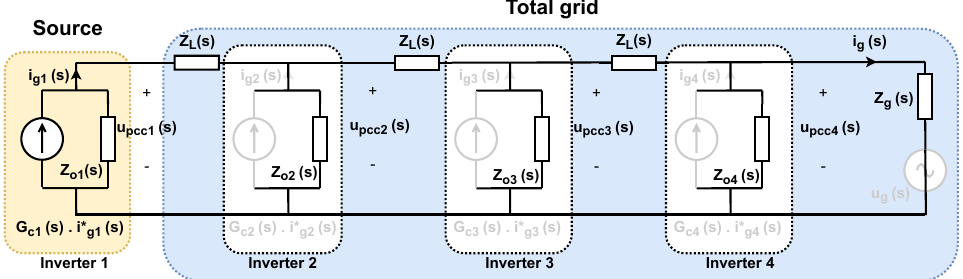
Figure 18. Equivalent impedance model of four identical inverters with the impact of the additional impedances between the connection points.